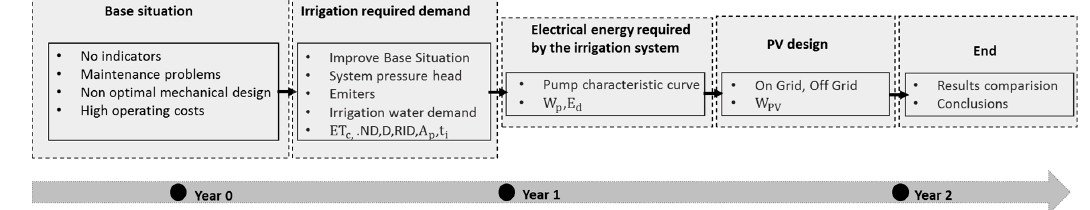
Figure 2. Proposed methodology for the implementation of a solar PV irrigation system.